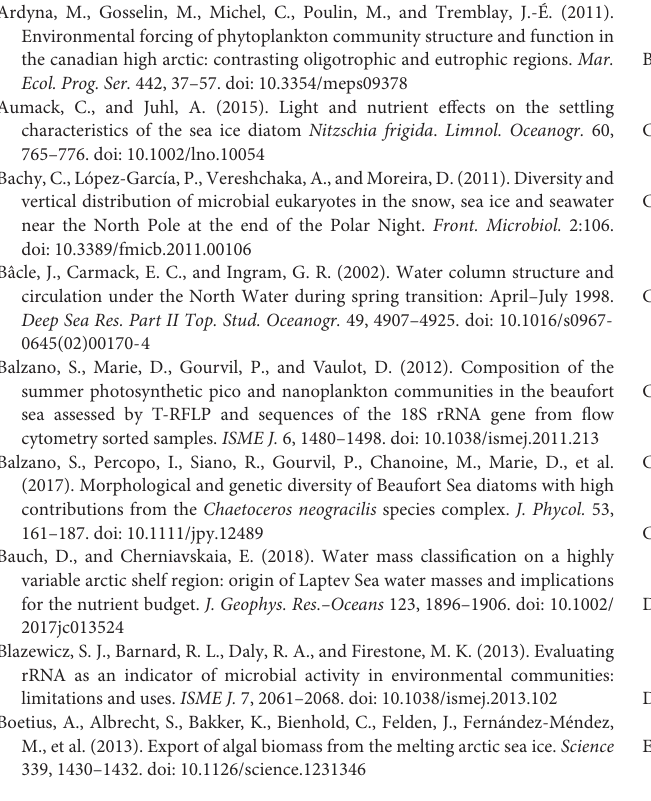
TABLE S1 | Sample ID is the station from Figure 1 main text and depth in meters (m), salinity (Sal) nitrate, phosphate, and silicate in micrometers, oxygen as percent saturation at depth and photosynthetically available radiation (PAR) as % attenuation relative to first surface reading, values < 0.01% are not shown. TABLE S2 | Additional contextual data. Trip depth is the actual depth (m) recorded as the sample bottle closed on the upward cast. The f CDOM (ppb) units refer to factory calibrations and Chl a concentrations (mg m − 3 ) estimated from relative fluorescence. Cell counts from FCM for bacteria